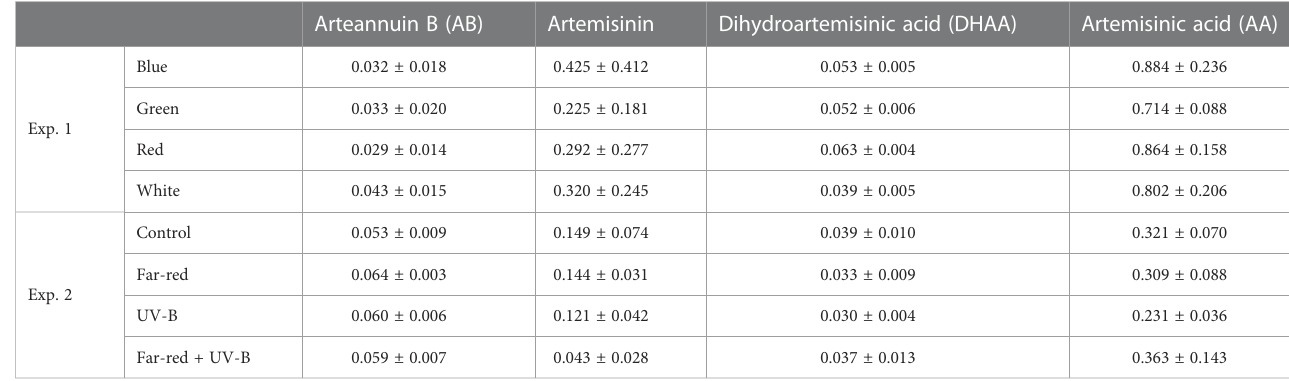
TABLE 1 Leaf secondary metabolite concentrations (mg g -1 leaf dry weight) in treatments with supplemental blue, green, red and white (Exp. 1), and in treatments with supplemental far-red and ultraviolet-B (UV-B) (Exp. 2). Values are mean ± s.e. (n = 4, with three plants in each statistical replicate). None of the data showed signi fi cant treatment effects.